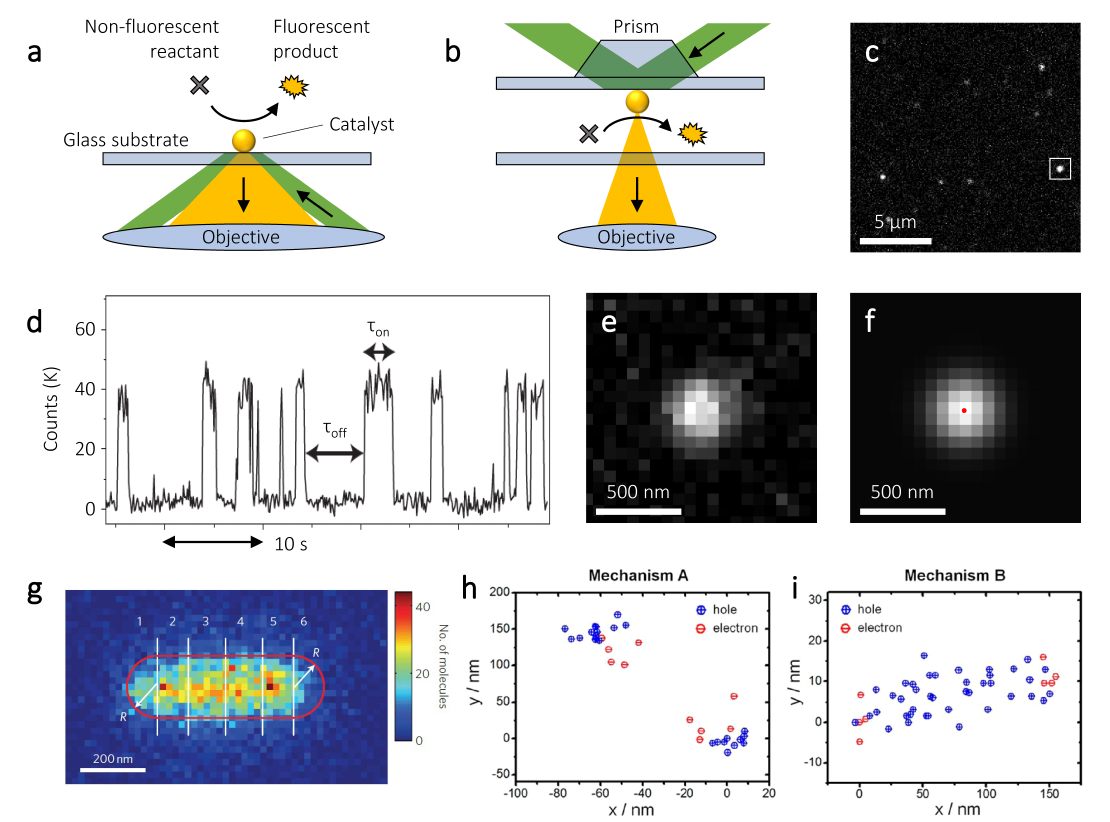
Figure 3. Super-resolution catalysis mapping on individual metal nanoparticles. ( a , b ) A non-fluorescent reactant converts to a fluorescent product, which can be imaged in an optical fluorescence microscope. Total internal reflection fluorescence (TIRF) illumination is achieved through the objective ( a ) or through a prism ( b ). ( c ) Widefield image with fluorescent events on multiple particles. ( d ) Time trace of the fluorescence intensity measured on a single catalytic particle; τ of f is the product formation time and τ on is the product desorption time. ( e , f ) A single fluorescent burst ( e ), corresponding to a single reaction product, can be fit to a two-dimensional Gaussian ( f ), which results in the position of the molecule (red dot in panel f). ( g ) Two-dimensional histogram of resorufin molecules detected on a single gold nanorod. The nanorod is divided in 6 segments and for each segment a specific turnover rate can be calculated. ( h , i ) Super-resolved locations of resorufin molecules detected on a single CdS-Au nanorod. Blue points correspond to hole-driven reactions and red points to electron-driven reaction. The nanorod is excited below bandgap with a 532 nm laser ( h ) or above bandgap with a 405 nm laser ( i ). Panels ( c , e , f ) are reproduced with permission of [110]. Copyright American Chemical Society, 2019. Panel ( d ) is reproduced with permission of [29]. Copyright Nature Publishing Group, 2008. Panel ( g ) is reproduced with permission of [31]. Copyright Nature Publishing Group, 2012. Panels ( h , i ) are reproduced with permission of [114]. Copyright American Chemical Society,